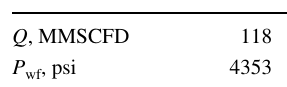
conditions of the target well